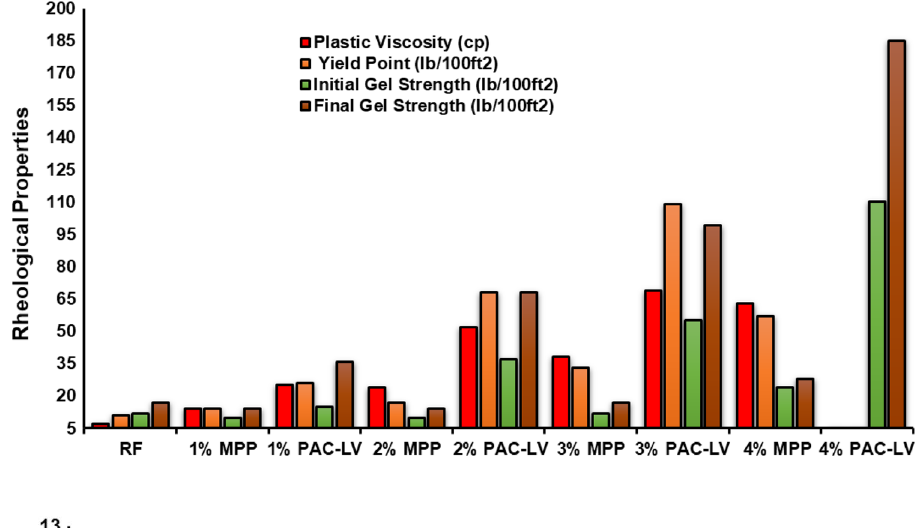
Fig. 11 The effect of MPP and PAC-LV filtration character- istics